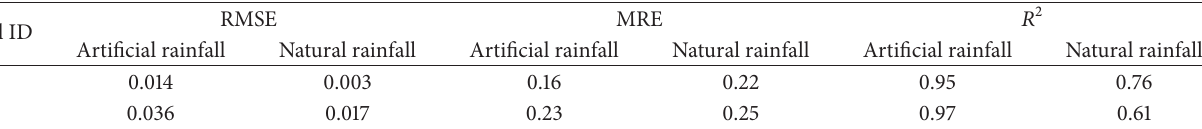
Table 3: Statistics for simulation accuracy assessment.